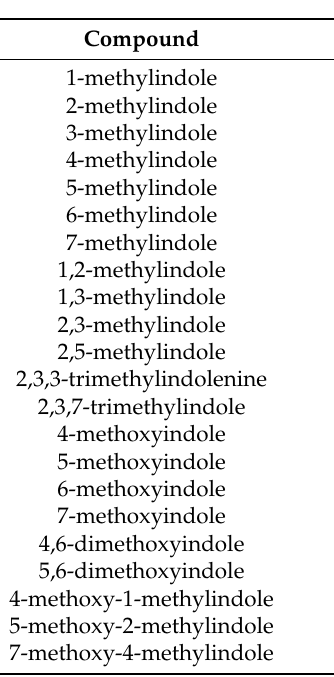
Table 3. List of used indolic compounds and